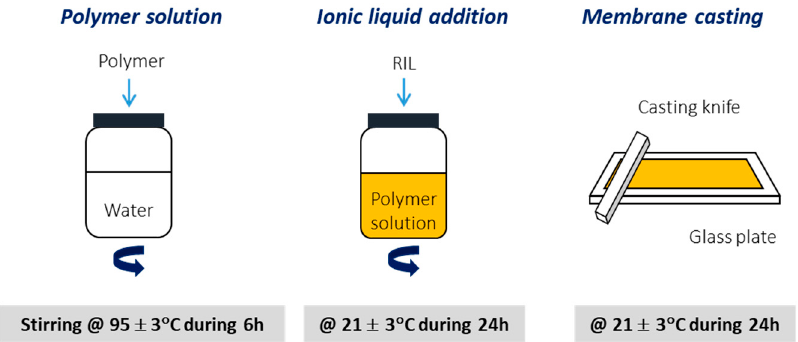
Figure 3. General scheme of poly(vinyl alcohol) (PVA)-RILs films fabrication.